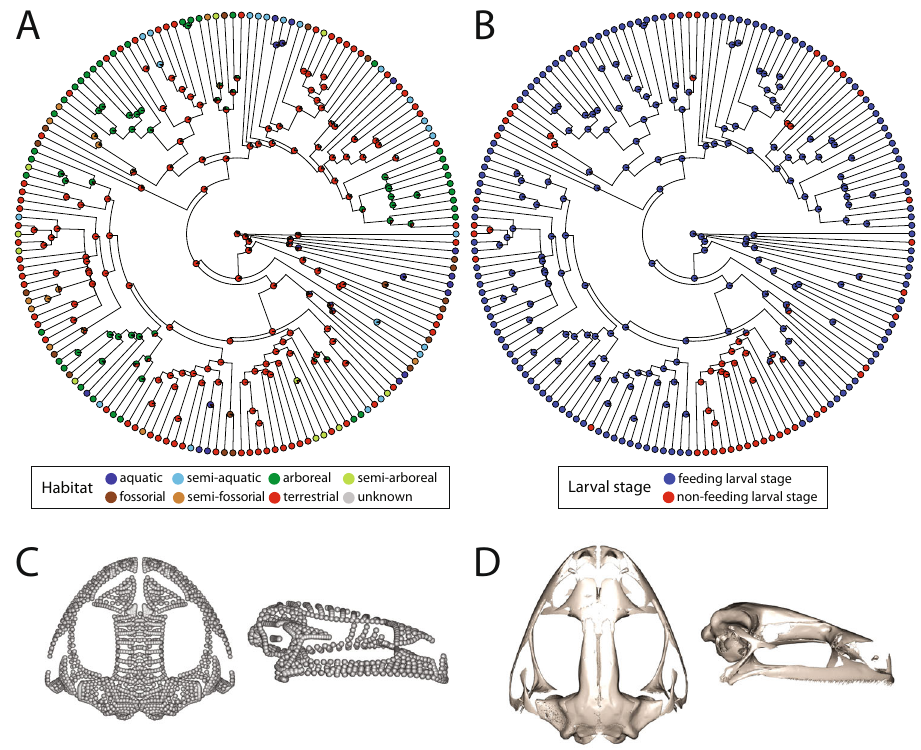
Fig. 3 Ancestral state and shape reconstructions. A Ancestral state estimation for microhabitat (Total N for microhabitat = 170, three specimens with missing microhabitat data, as described in Methods). B Ancestral state estimation for larval feeding (Total N for larval feeding = 163, ten specimens with missing larval feeding mode data, as described in Methods). C Ancestral shape reconstruction for cranial shape in dorsal (left) and lateral (right) aspect. D Specimen cranium closest in shape to the ancestral shape reconstruction ( Minervarya nilagirica , MNHN:RA:19842337) in dorsal (left) and lateral (right)